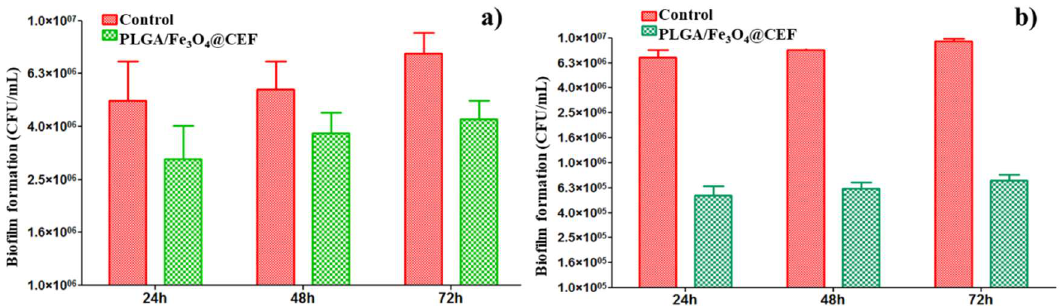
Figure 9. Biofilm development inhibition of E. coli ( a ) and S. aureus ( b ) in the presence of PLGA/Fe 3 O 4 @CEF coatings.